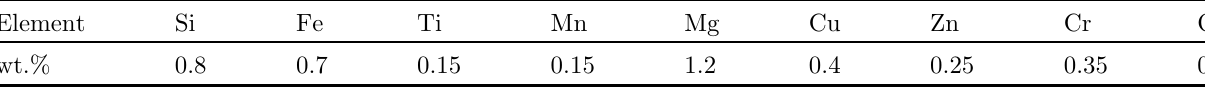
Table 2. Castings nomenclature. Sample